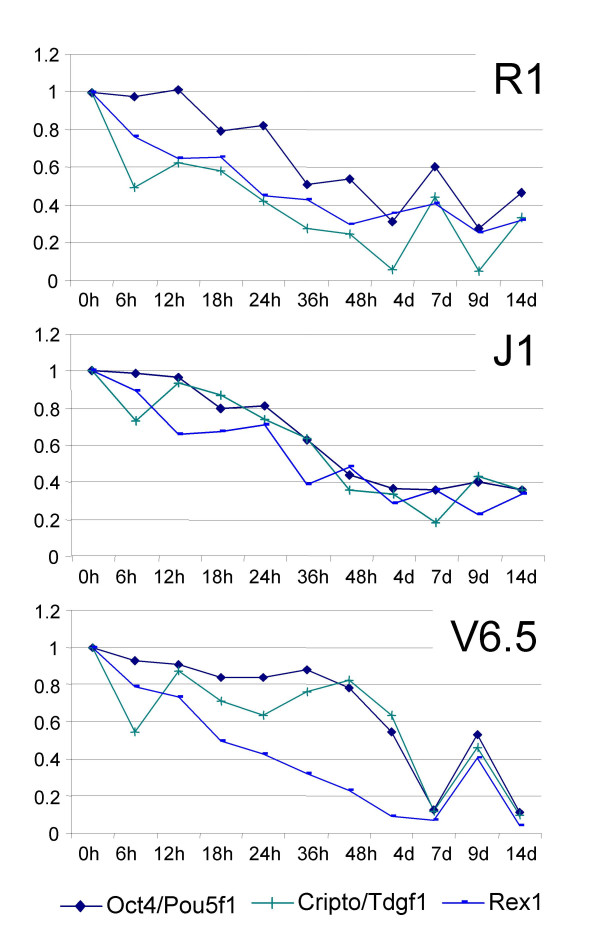
Marker genes (Oct4/Pou5f1, Cripto/Tdgf1, and Rex1) expression pattern in the three time series. The identifiers of the probe sets used were 1417945_at (for Oct4/Pou5f1), 1450989_at (for Cripto/Tdgf1), and 1418362_at (for Rex1). Signal values were normalized to the value at 0 h.